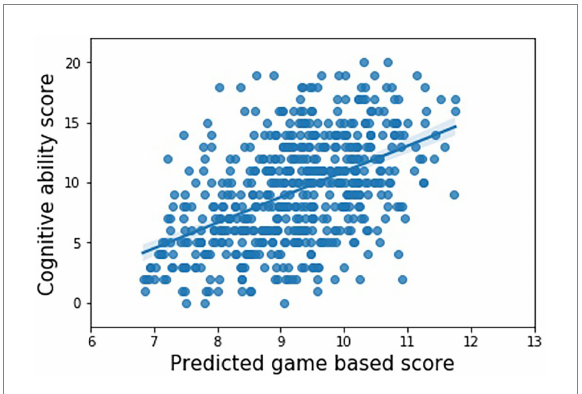
FIGURE 1 Observed questionnaire based and predicted game based cognitive ability scores using the ridge regression model with bias penalisation (Pearson’s r = 0.50).